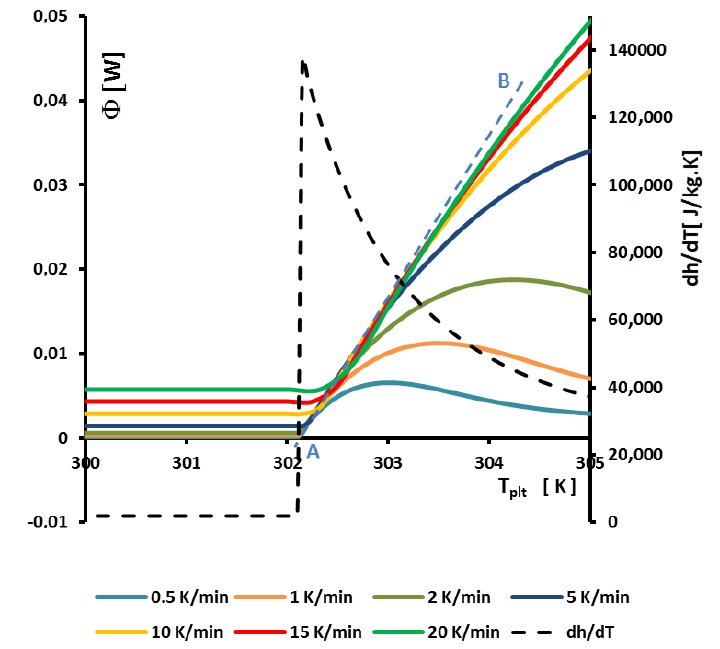
Figure 29. Determination of T solidus the temperature of the solidus for x 0 = 0.2; from